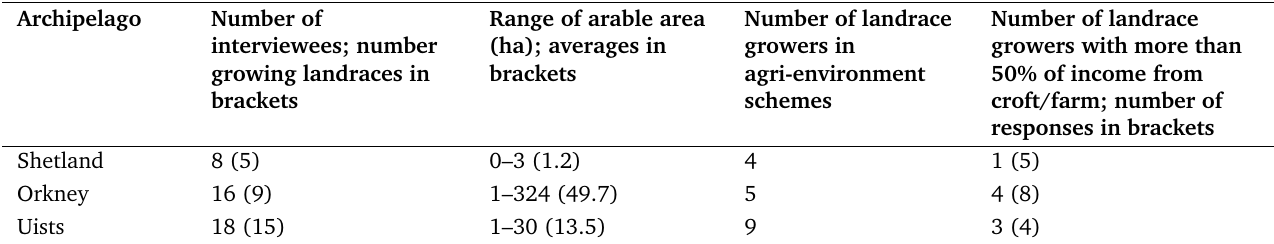
Table 3. Summary of respondent characteristics in the 2018 survey by Scottish Isle